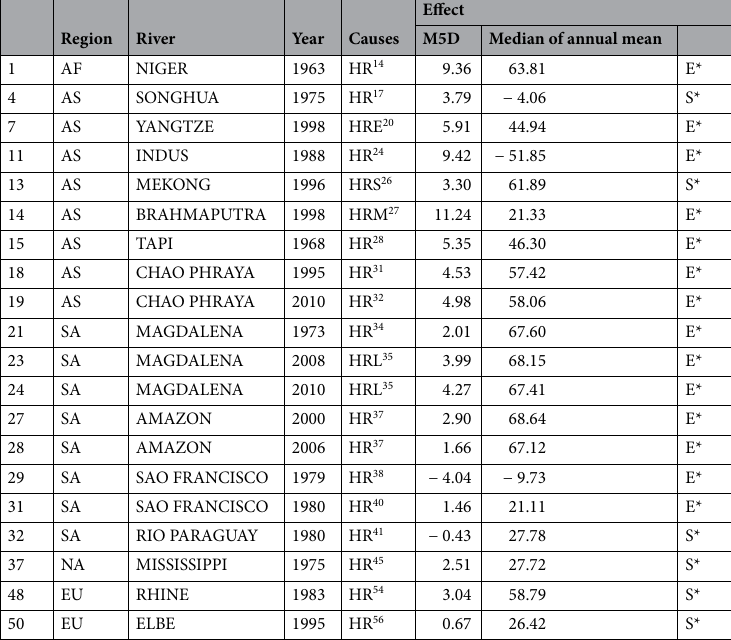
Table 1. Summary of selected flood events with significant effects of human-induced climate change (E, enhanced; S, suppressed). Changes in climate variables are derived as the average of the upper basin area of the station (number of GRDC stations are given in Supplementary Table 1). The numbers correspond to the event number in the Supplementary Table S1. AF, Africa; AS, Asia; EU, Europe; SA, South America; NA, North America; OC, Oceania; N/A, not available. HR, Heavy rain; M, monsoon; E, El Nino; S, Strom; L, La Niña; SM, Snowmelt. M5D, annual maximum daily precipitation. Asterisks indicate very likely (90th percentile) changes.